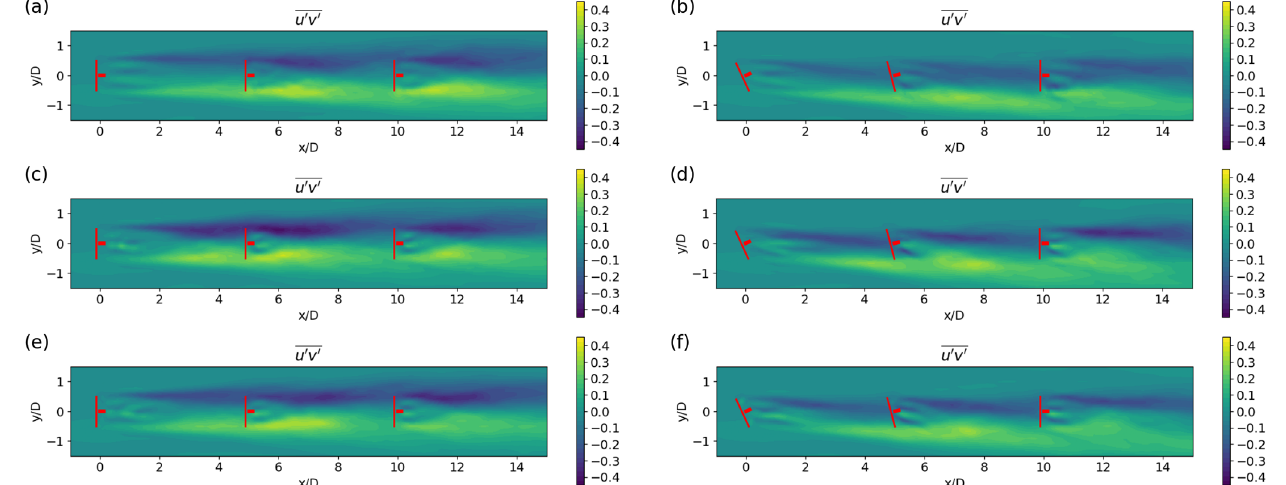
Figure 12. Top-view contours of the turbulence flux u (cid:48) v (cid:48) (m 2 s − 2 ) in the x − y plane at hub height obtained from LES using the ADM- std, ADM-BE and ALM. The lateral offset of the turbines is zero (Cases 1 and 2). (a) The ADM-std, γ = (0 , 0 , 0 ◦ ); (b) the ADM-std, γ = (25 , 15 , 0 ◦ ); (c) the ADM-BE, γ = (0 , 0 , 0 ◦ ); (d) the ADM-BE, γ = (25 , 15 , 0 ◦ ); (e) the ALM, γ = (0 , 0 , 0 ◦ ); (f) the